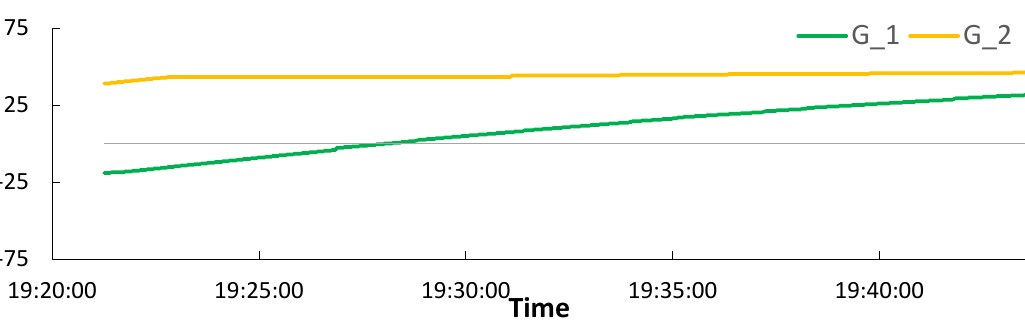
Figure 15. Plot of U-component deviations of static measurements with code receivers.